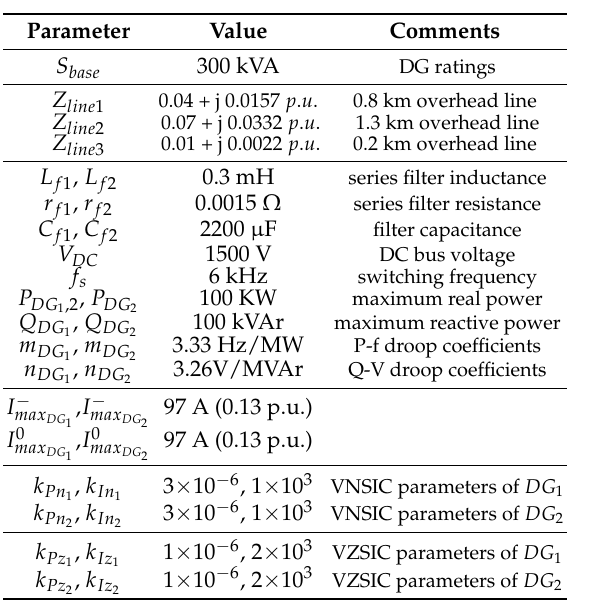
Table 2. MG system